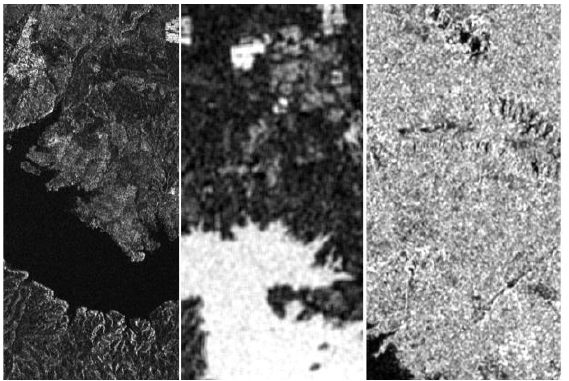
Figure 2. Example for S1 textures: